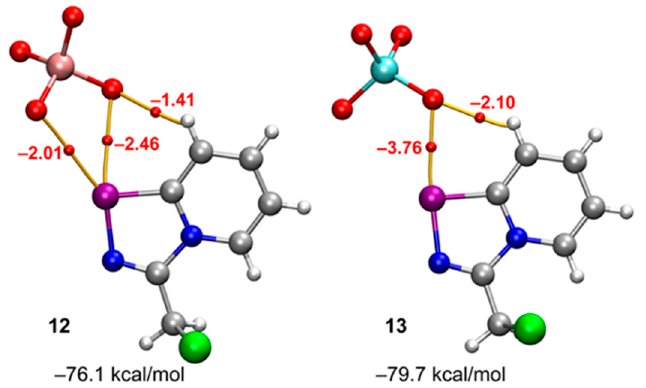
Figure 10. QTAIM analyses of compounds 12 and 13 . Only intermolecular bond CPs and bond paths are represented. The energies of the ChB and HB contacts are indicated next to the bond CPs (small red spheres) in kcal/mol.